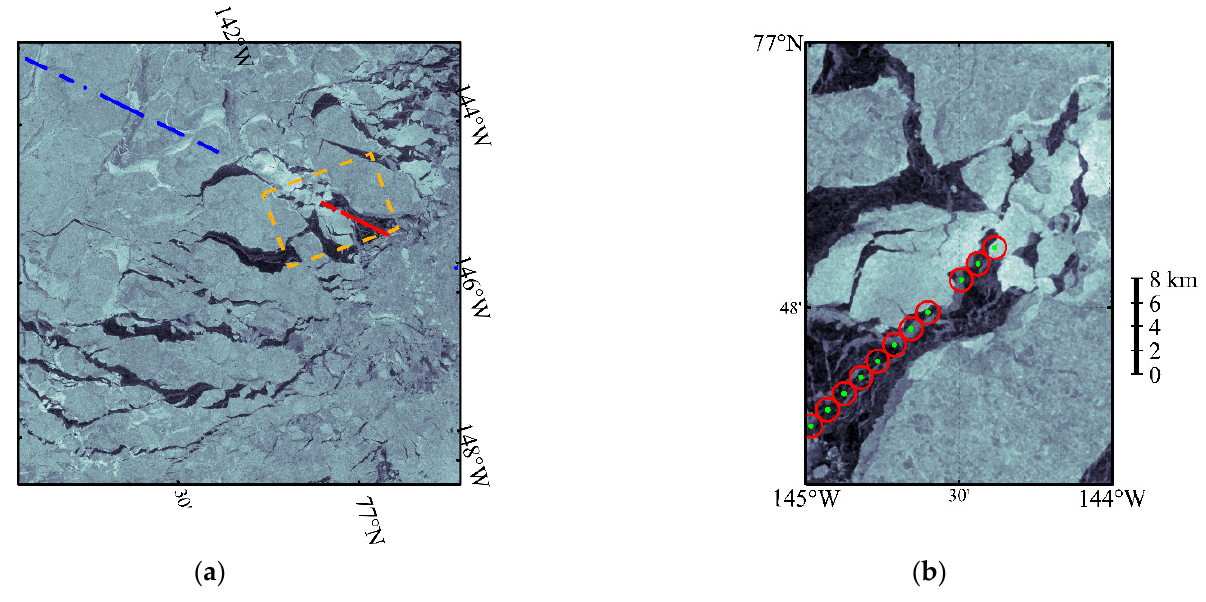
Figure 6. Example of ground truth and sea ice concentration for the HY-2B radar altimeter using Sentinel-1 SAR images: ( a ) ground truth example; ( b ) examples of different sea ice concentrations within the radar pulse-limited footprint.